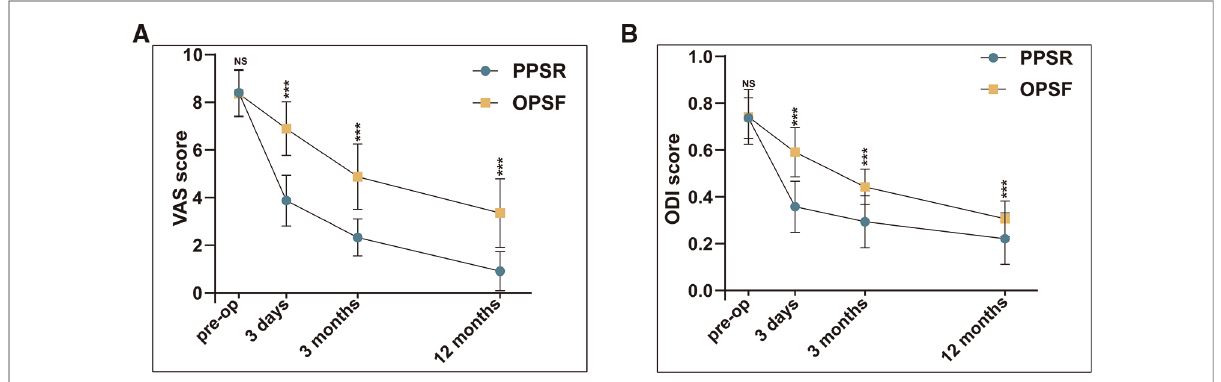
FIGURE 5 Comparison of clinical outcomes between the PPSR group and OPSF group. ( A ) The VAS scores between the PPSR group and OPSF group. ( B ) The ODI scores between the PPSR group and OPSF group. NS indicates no signi fi cance. Data are presented as the mean±SD. *: P <0.05, **: P <0.01, ***: P